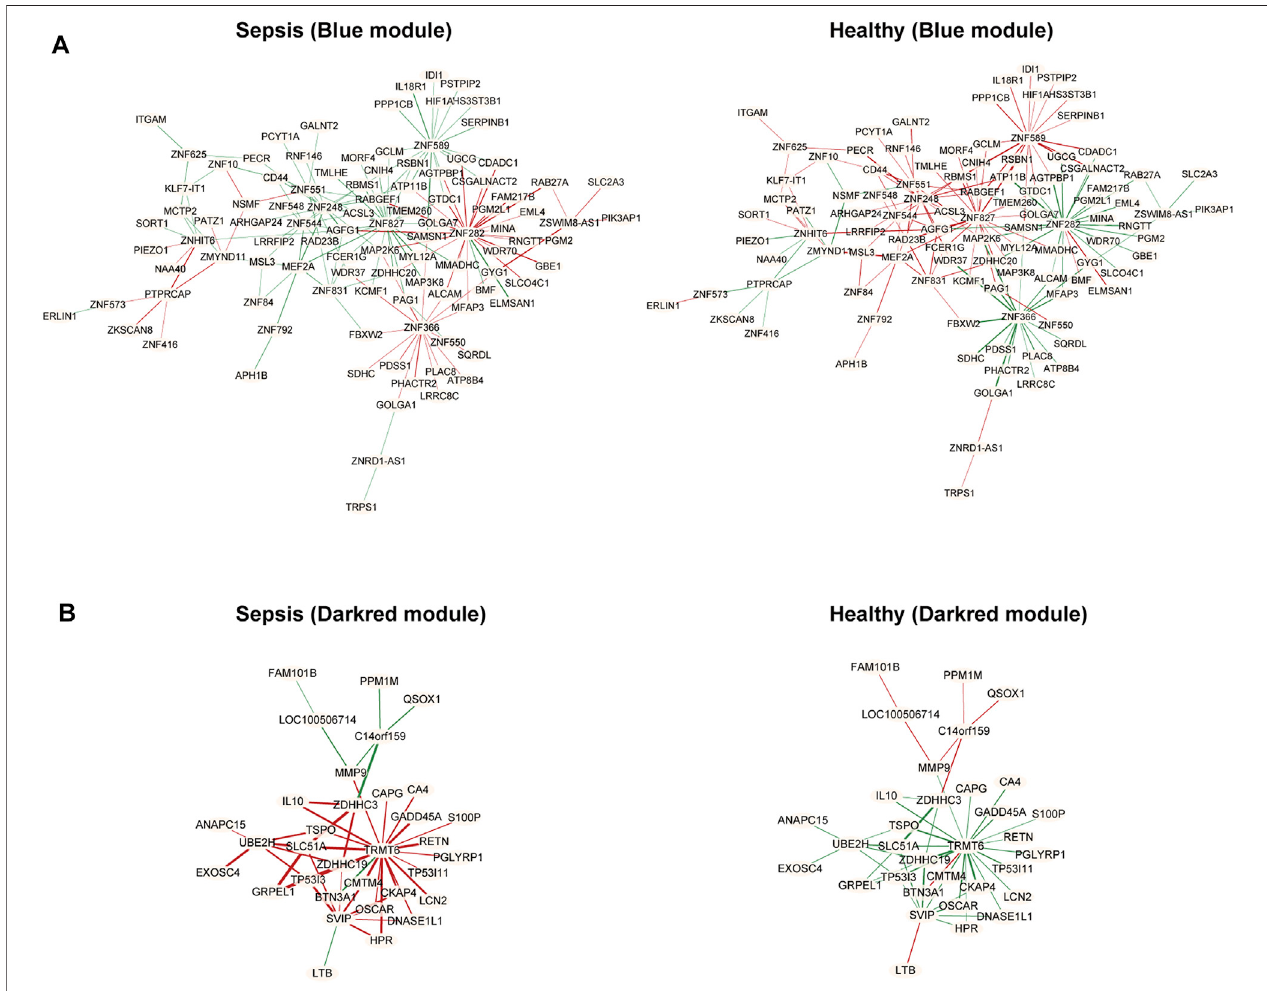
FIGURE 5 | Differential co-expressed gene networks in the blue (A) and darkred (B) modules from GSE134347. Each node represented one gene. Each edge represented correlation between two genes, in which red meant positive correlation and green negative correlation. The thicker edge represented the stronger correlation coef fi